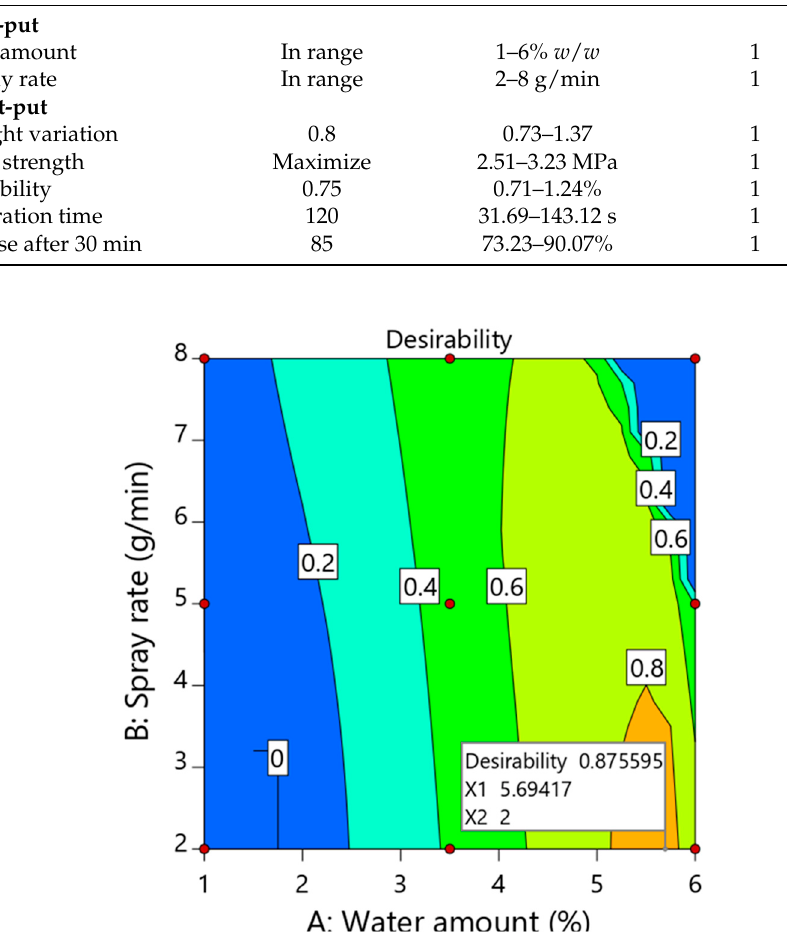
Figure 4. Optimization plot showing the influence of water amount (X 1 ) and spray rate (X 2 ) on overall desirability. Table 10. The constraints adopted for developed design space. Table 11. Predicted and experimental values of optimized run with their prediction